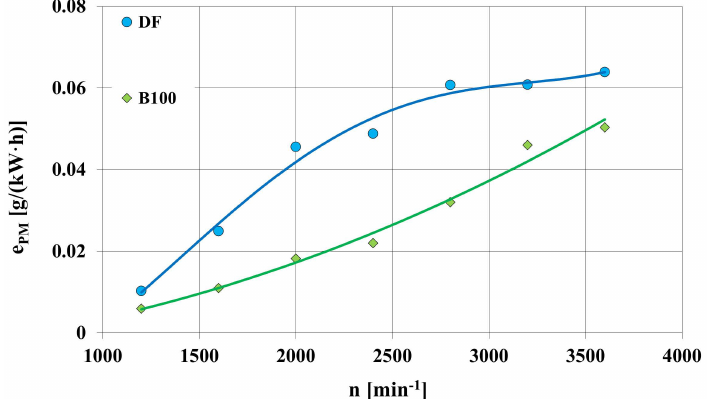
Figure 8. External speed characteristics of the specific brake emission of particulate matter-e PM in the rotation speed domain-n for the engine powered with fuels DF diesel or B100.